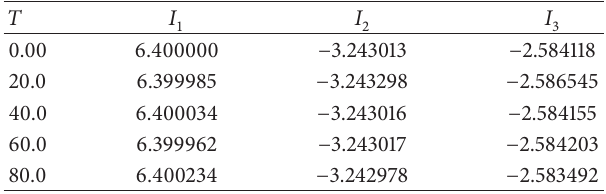
Table 4: Two solitons interaction (conserved